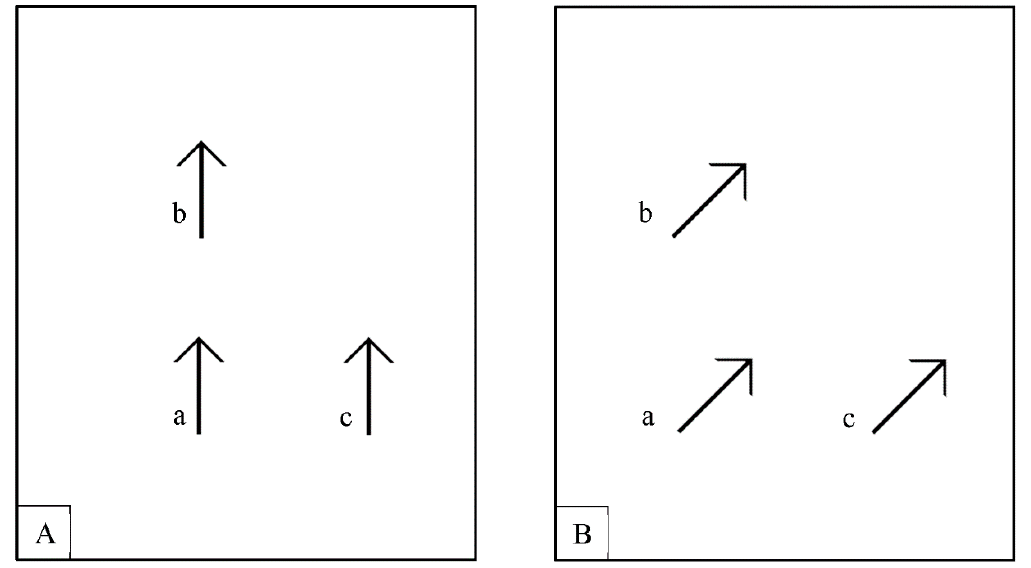
Figure 2. ( A , B ) Two examples of the display in Static Session, where “b” arrows are in a position which is collinear to the position of the central arrows, here denoted with “a”. The figure is not drawn to scale.